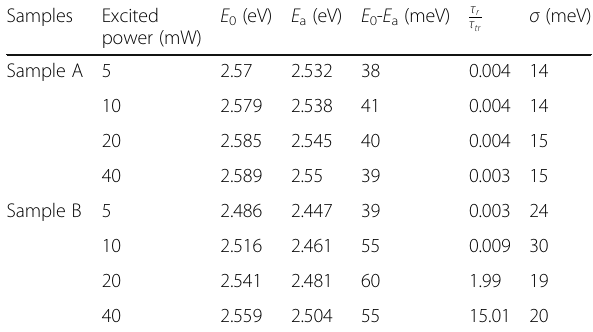
Table 2 Fitting parameter in the LSE model for two samples